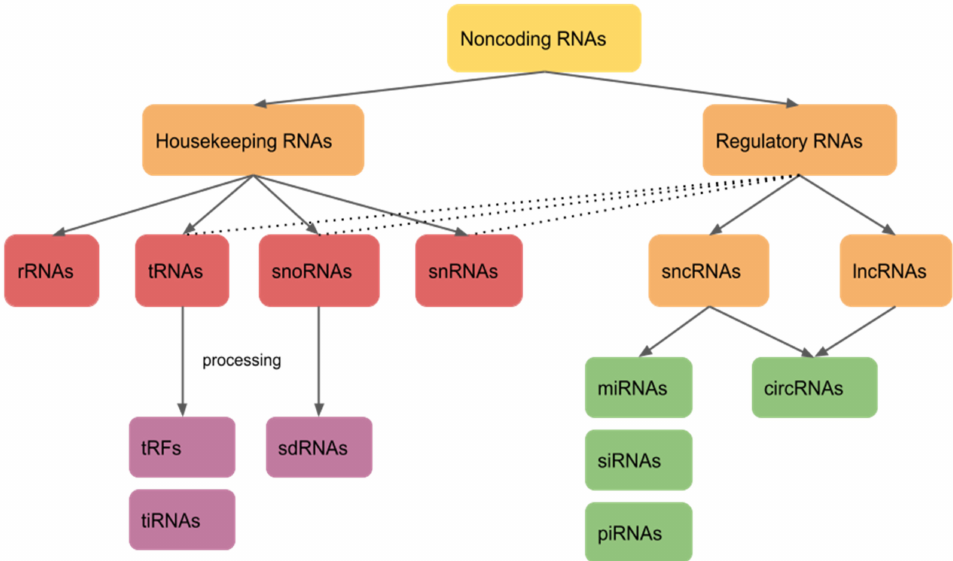
Figure 1. Classification of noncoding RNAs. Noncoding RNAs are divided into housekeeping RNAs and regulatory noncoding RNAs. Housekeeping RNAs include rRNAs, tRNAs, snoRNAs, and snRNAs. tRNAs and snoRNAs can be further processed into tRFs and sdRNAs, respectively. Regulatory RNAs are divided into sncRNAs and lncRNAs. sncRNAs include miRNAs, siRNAs, and piRNAs. Furthermore, circRNAs can be categorized as either sncRNAs or lncRNAs based on their